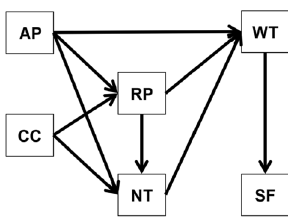
Figure 2. The SEM of this study.